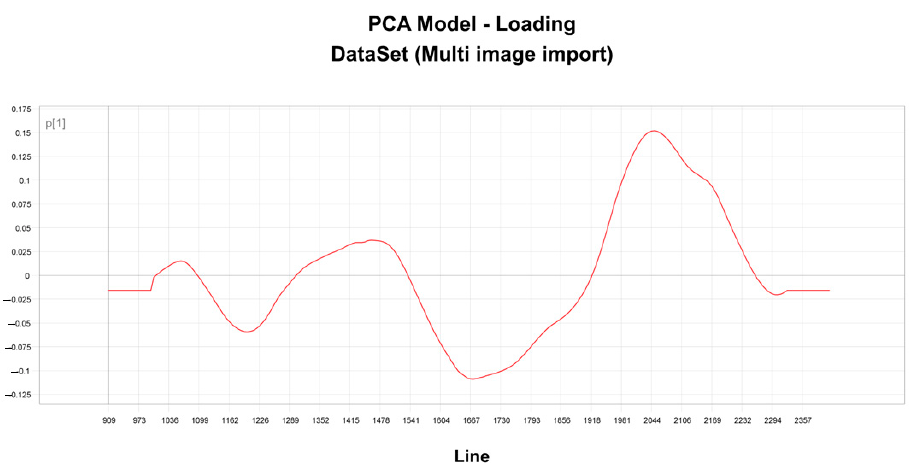
Figure 4. Load line of vector P1 for the score image showing variables responsible for the separation of resistance and sensitivity.